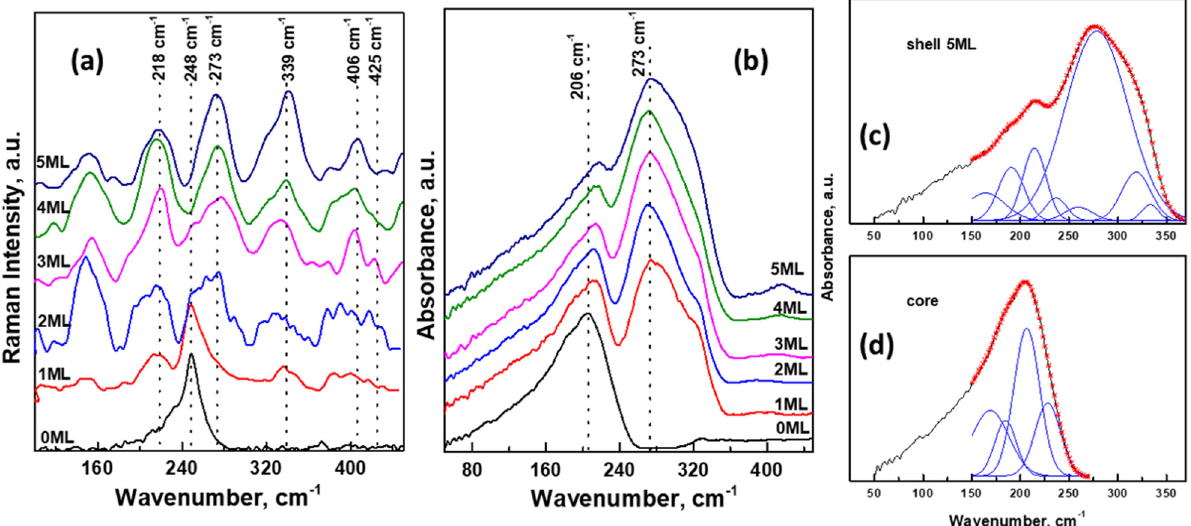
Figure 7. Raman ( a ) and ATR ( b ) spectra of Cd 0.25 Zn 0.75 Se/ZnS (0–5 MLs) in the region 50–450 cm − 1 ; the decomposition of ATR spectra of Cd 0.25 Zn 0.75 Se/ZnS (5 MLs) ( c ) and core ( d ).